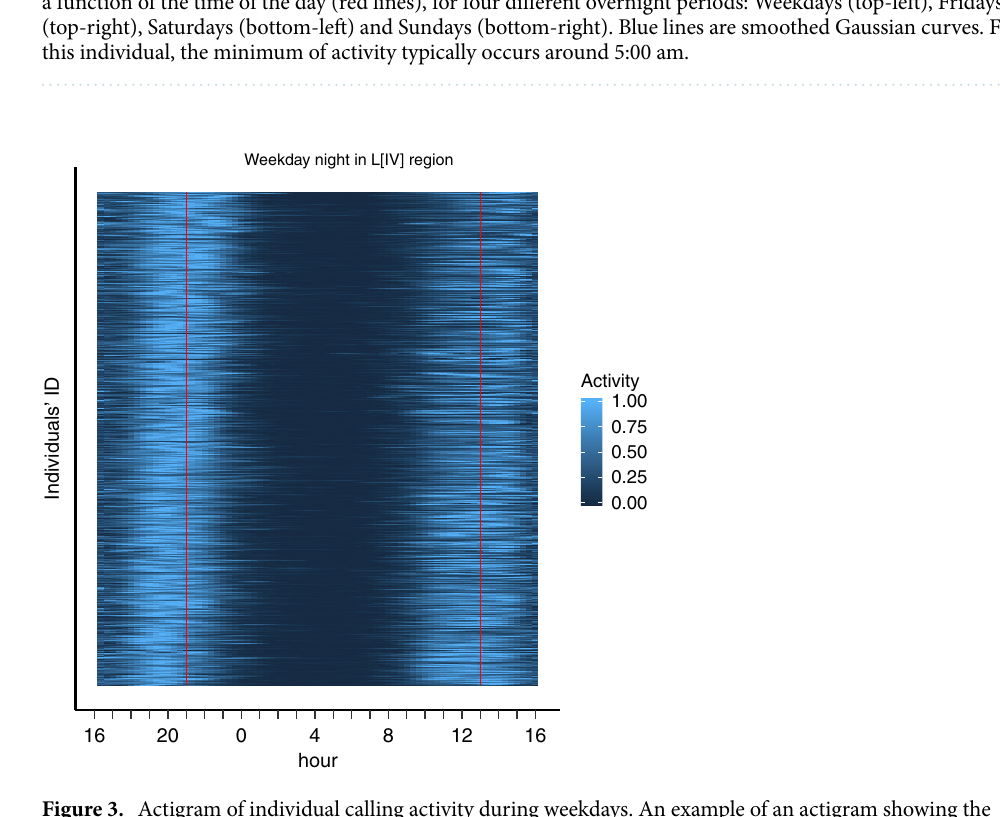
Figure 3. Actigram of individual calling activity during weekdays. An example of an actigram showing the calling activity for weekdays’ overnight periods of 1560 individuals chosen from the longitudinal band L IV (similar patterns exist for the other bands). Each individual calling activity correspond to a horizontal line in the actigram, and each individual activity is scaled into the interval [0, 1] such that the most active periods are represented by light regions and periods without activity by dark regions. To show that individuals’ period of low activity (chronotypes) are not homogeneous, we ordered the presented individual activity profiles according to time shift between each profile and the mean over the population’s activity profiles (i.e. using the time shift that maximizes the cross-correlation between the individual profile and the mean). In this representation, “larks” or morning people appeared in the bottom section of the actigram, with their activity profile clearly shifted towards early hours, whereas “owls” or evening people (top section of the plot) are clearly shift towards late